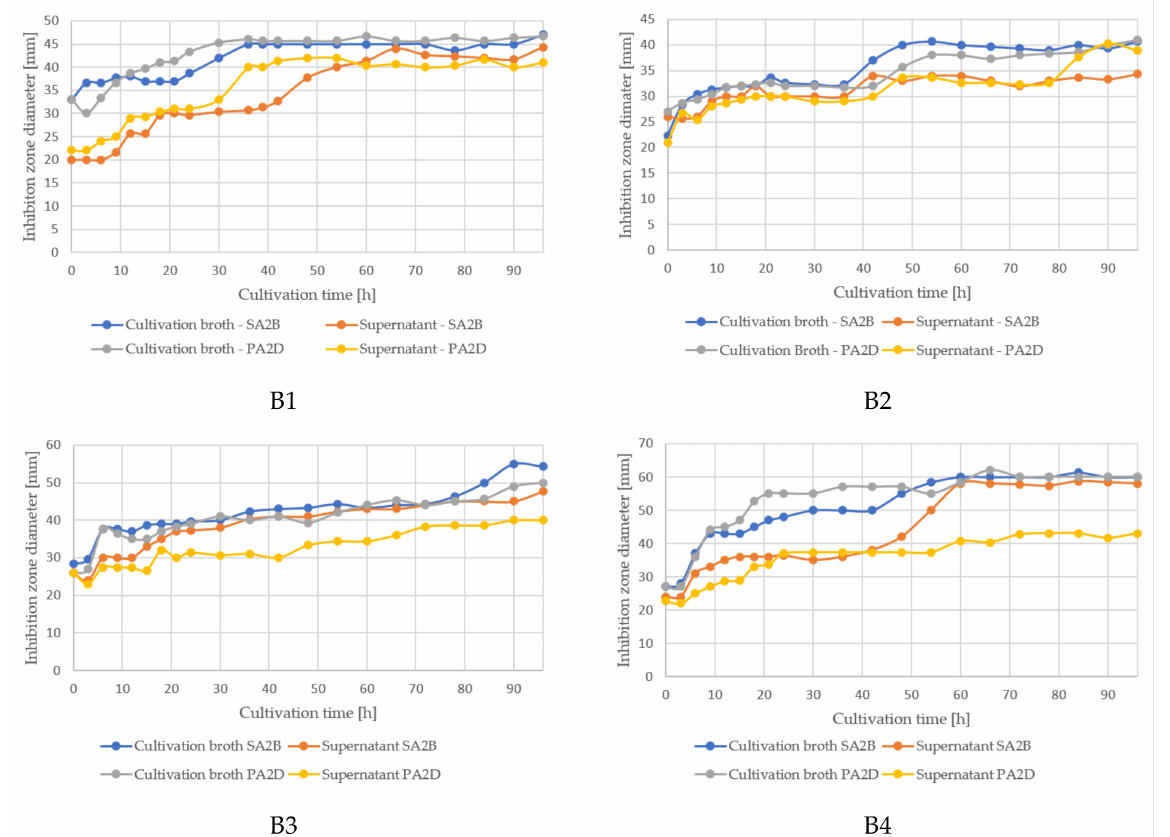
Figure 4. Antimicrobial activity assay of cultivation broth and cell-free supernatant samples of the producing microorganism Bacillus sp. BioSol021 against A. flavus strains SA2B and PA2D under different bioprocess parameters: B1: 0.5 vvm, 100 rpm; B2: 0.5 vvm, 300 rpm; B3: 1.5 vvm, 100 rpm; B4: 1.5 vvm, 300 rpm.